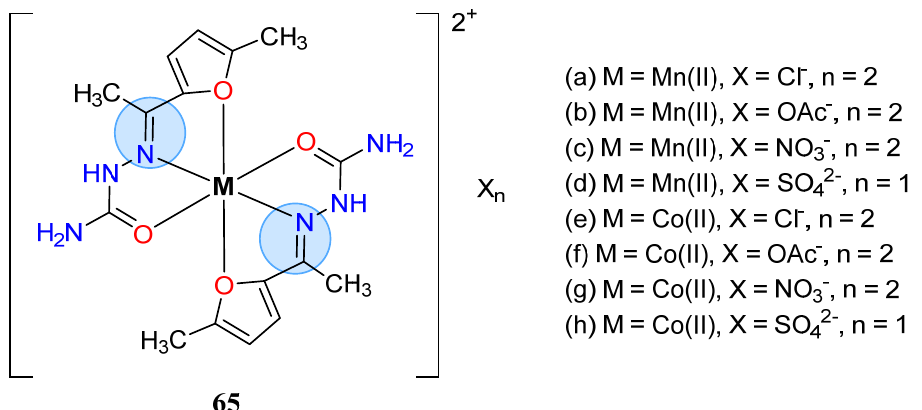
Figure 29. Mn(II) and Co(II) complexes with Schiff base ligand derived from semicarbazone with antimicrobial activity.